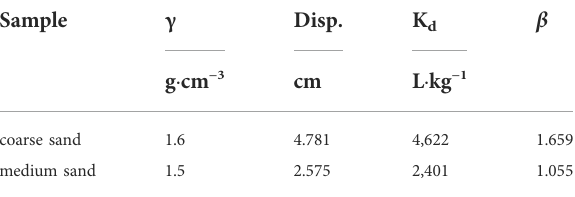
TABLE 2 Time-variable boundary conditions.